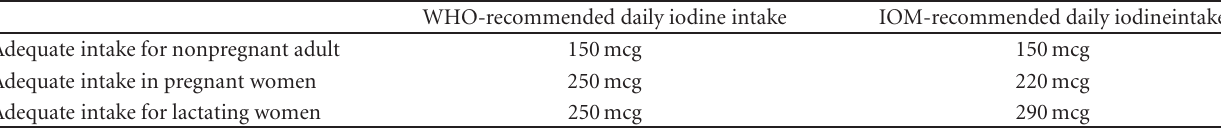
Table 2: World Health Organization (WHO) and Institute of Medicine (IOM) recommendations for dietary iodine intake [10,